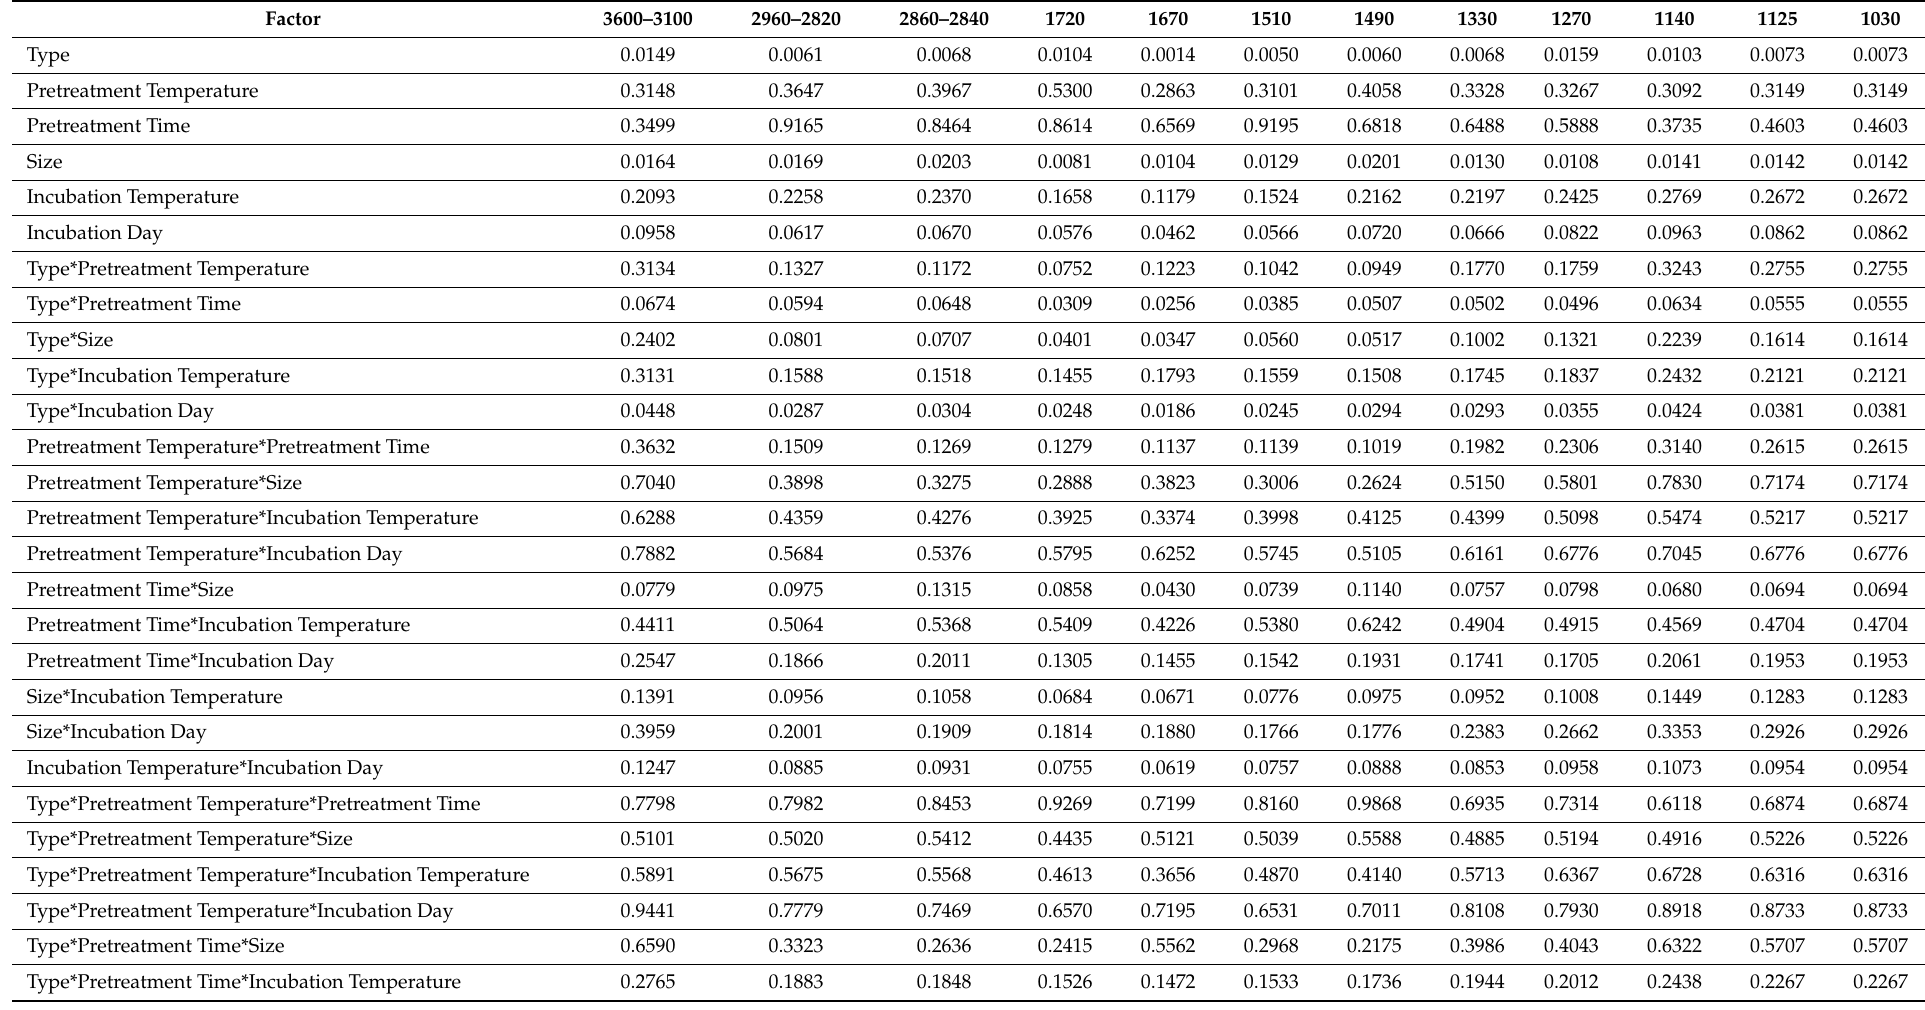
Table 12. p -value summary for CEL FTIR